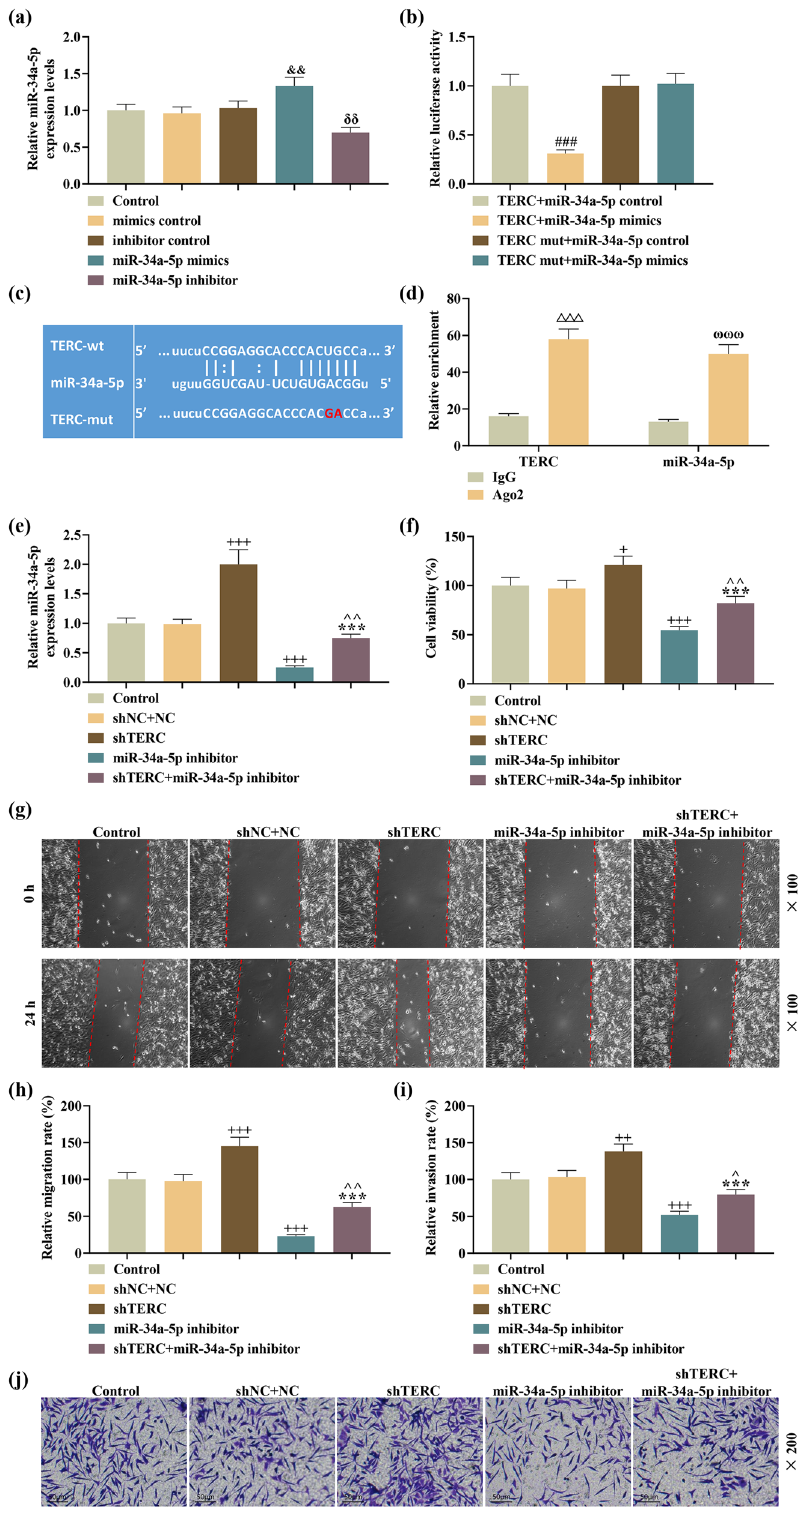
Figure 4: DownregulationofmiR - 34a - 5p,atargetofTERC,o ff setTERCknockdown - inducede ff ectsonviability,migration,andinvasionofLPS - inducedPC - 12 cells. ( a ) The expression of miR - 34a - 5p in miR - 34a - 5p mimic/inhibitor - transfected PC - 12 cells after LPS treatment was analyzed by qRT - PCR. ( b – d ) The interaction between TERC and miR - 34a - 5p was checked by ( b ) dual - luciferase reporter assay, predicted by ( c ) TargetScan V7.2, and rea ffi rmed by ( d ) RIP assay. ( e ) The expression of miR - 34a - 5p in miR - 34a - 5p inhibitor and/or shTERC - transfected PC - 12 cells after LPS treatment was determined by qRT - PCR. ( f ) TheviabilityofmiR - 34a - 5pinhibitorand/orshTERC - transfectedPC - 12cellsafterLPStreatmentwasmeasuredbyCCK - 8assay. ( gandh ) Themigratoryability of miR - 34a - 5p inhibitor and/or shTERC - transfected PC - 12 cells after LPS treatment was evaluated by wound healing assay ( magni fi cation: × 100; scale: 100µm ) . ( i and j ) . The invasive ability of miR - 34a - 5p inhibitor/shTERC - transfected PC - 12 cells after LPS treatment was assessed by Transwell assay ( magni fi cation: × 200; scale: 50µm ) . + P or ^ P < 0.05; && P or δδ P or ++ P or ^^ P < 0.01, ### P or +++ P or *** P < 0.001, △△△ P < 0.001; ωωω P < 0.001; & vs mimics control; δ vsinhibitorcontrol; # vsTERC + miR - 34a - 5pcontrol; + vsshNC + NC; * vsshTERC; ^ vsmiR - 34a - 5pinhibitor; △ vsIgGinTERC; ω vsIgGinmiR - 34a -